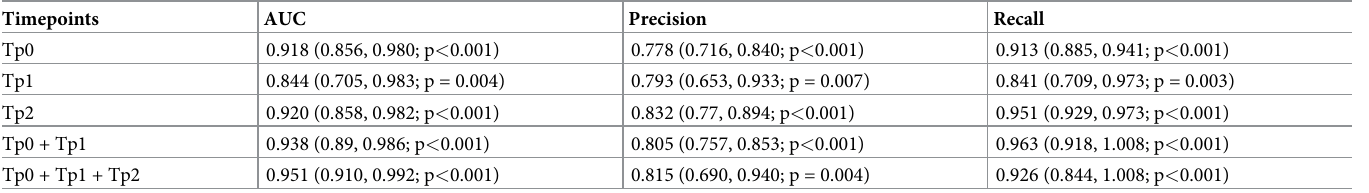
Table 4. Model performances for models trained on all features restricted to tp0, tp1, tp2, tp0 + tp1 and all timepoints using 5-fold